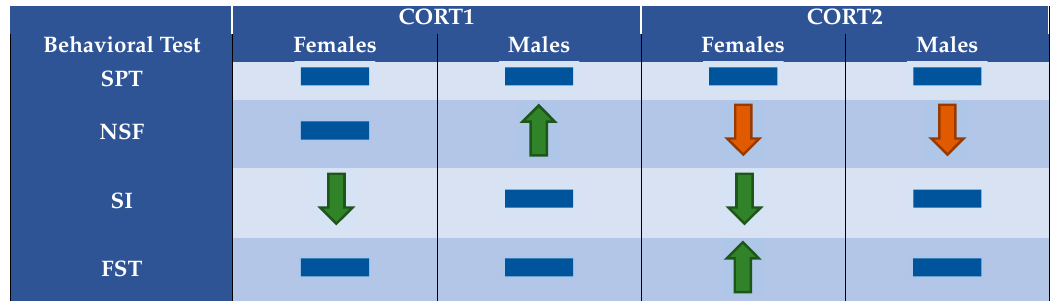
Figure 5. Behavioral despair in the Forced Swim Test in CORT mice. Behavioral analysis in the Forced Swim Test evaluating relative immobility time in ( a – b ) female ( c – d ) male CORT treated in and Vehicle control mice. All values are presented as mean ± SEM ( n = 11–15 per group). Statistical significances are results of Student‘s t-test. * p < 0.05. Table 1. Summary of behavioral phenotypes. Summary of behavioral phenotype referring to the depression- like behavior in the different treatment groups. Green arrows show increased depression- like behavior, red arrows indicate decreased depression- like behavior and blue lines present no effect according to the behavioral outcome of the respective test.